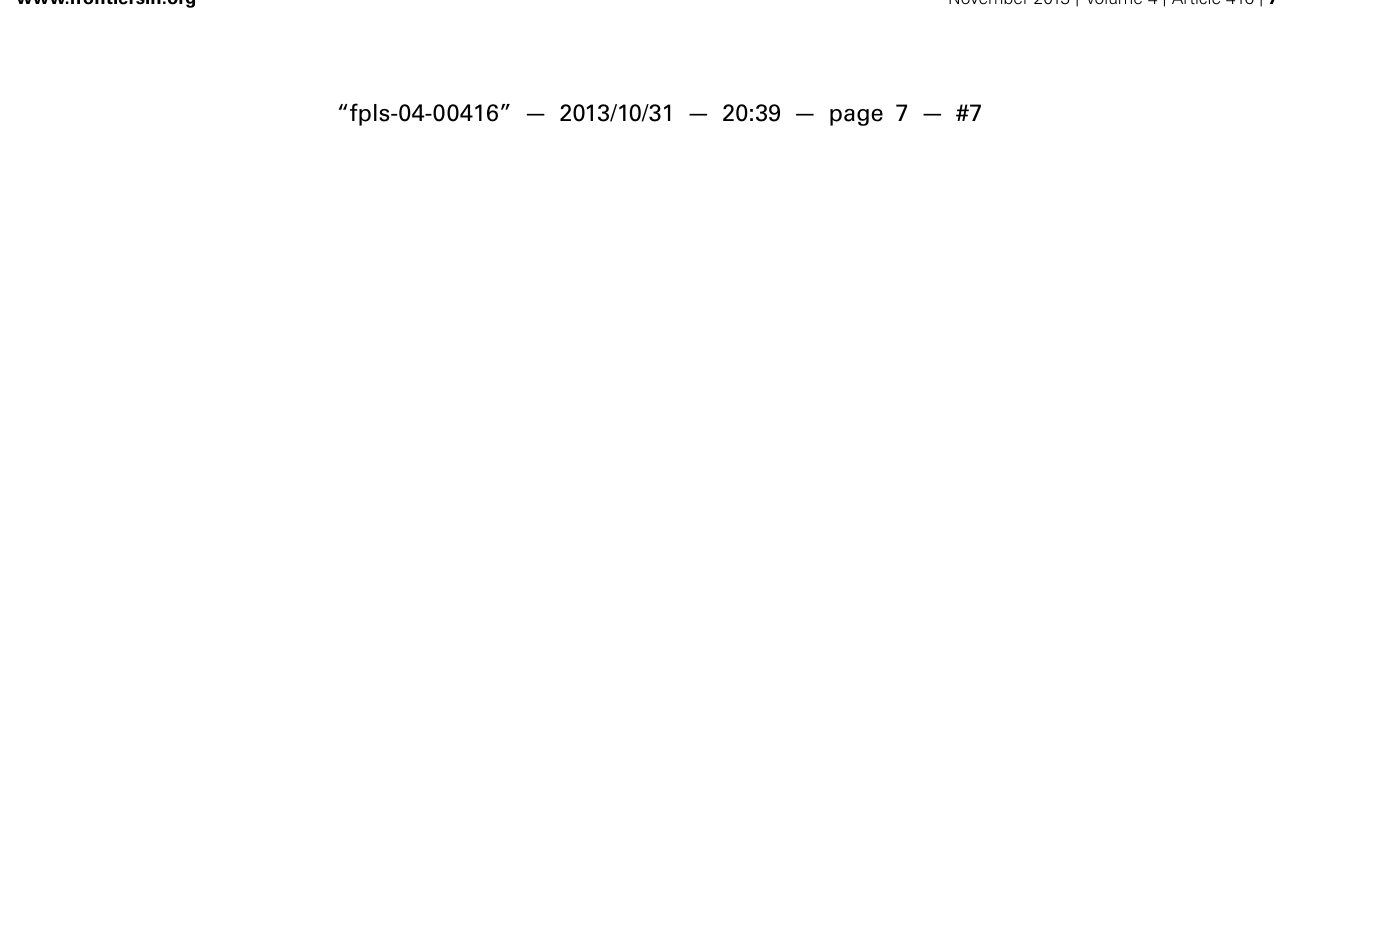
addition of hydrogen peroxide (H 2 O 2 ) or paraquat (PQ), or high salt (sodium chloride, NaCl), or osmotic stress (sorbitol). For the high light treatment (closed bars, (D) ) seedlings were either grown under 150 μ mol m − 2 s − 1 irradiance for 14 days (open columns) or they were grown under 150 μ mol m − 2 s − 1 irradiance for 10 days and then transferred to 400 μ mol m − 2 s − 1 irradiance for 4 days prior to measurement.The asterisks indicate significant differences ( p < 0.05;